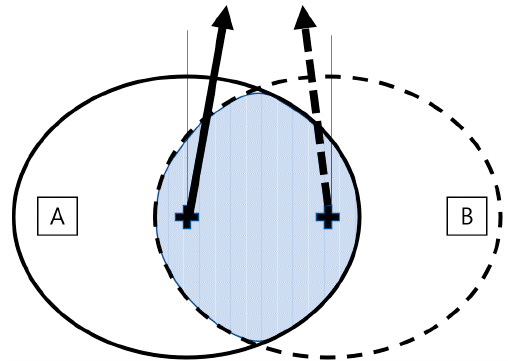
Figure 5. The criteria to determine the merging of two debris-flow clusters A and B by comparing the travel directions and assessing the number of debris-flow particles in the overlapping region.